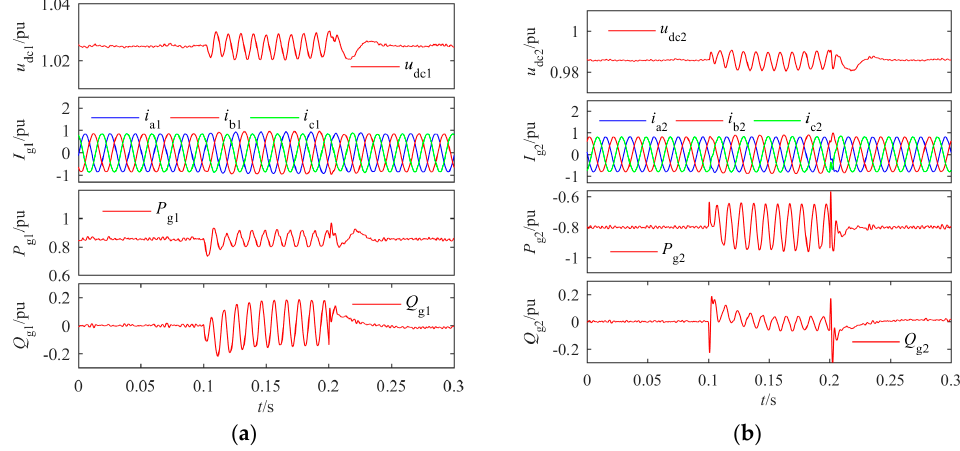
Figure 9. Responses of CS1 ( a ) and CS2 ( b ) to the SOC for OBJ 5.